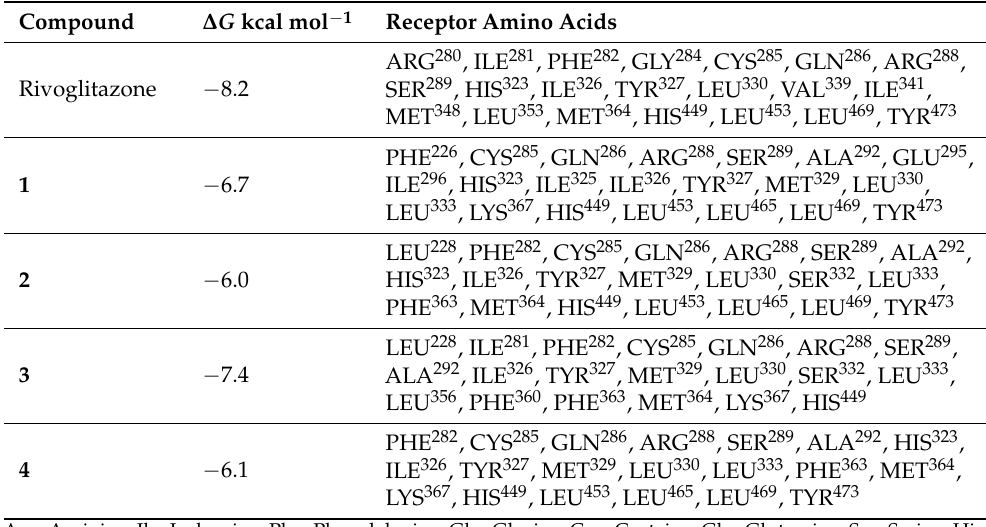
Table 2. Molecular docking parameters for the interaction of isolated SI fatty acids ( 1 – 4 ) with PPAR- γ . Compound ∆ G kcal mol − 1 Receptor Amino